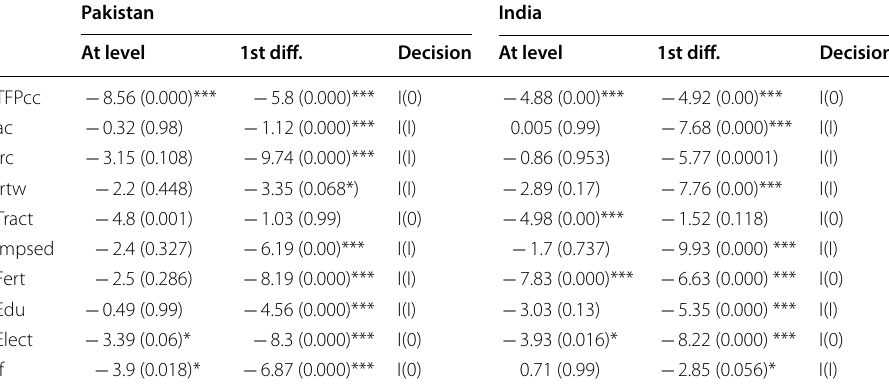
Table 1 Unit root